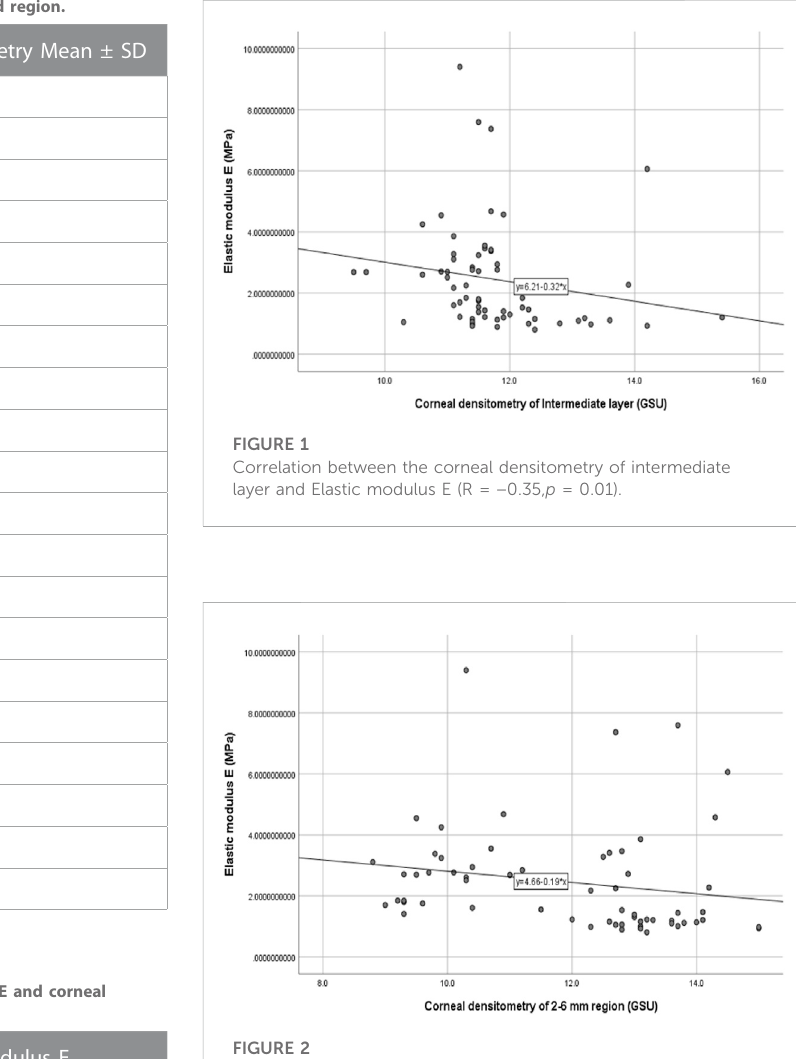
Table 4. Most corneal densitometry values which had a correlation were distributed at the 0 – 6 mm central region of cornea.